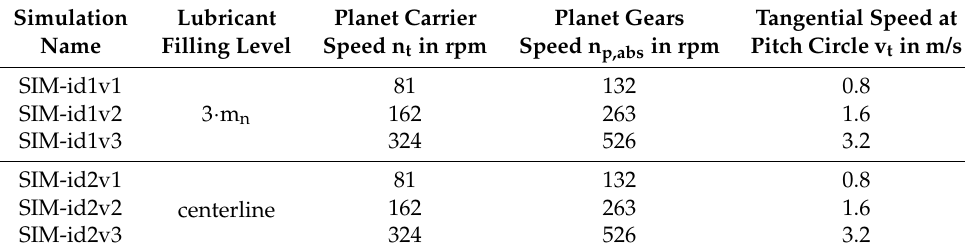
Table 3. Operating